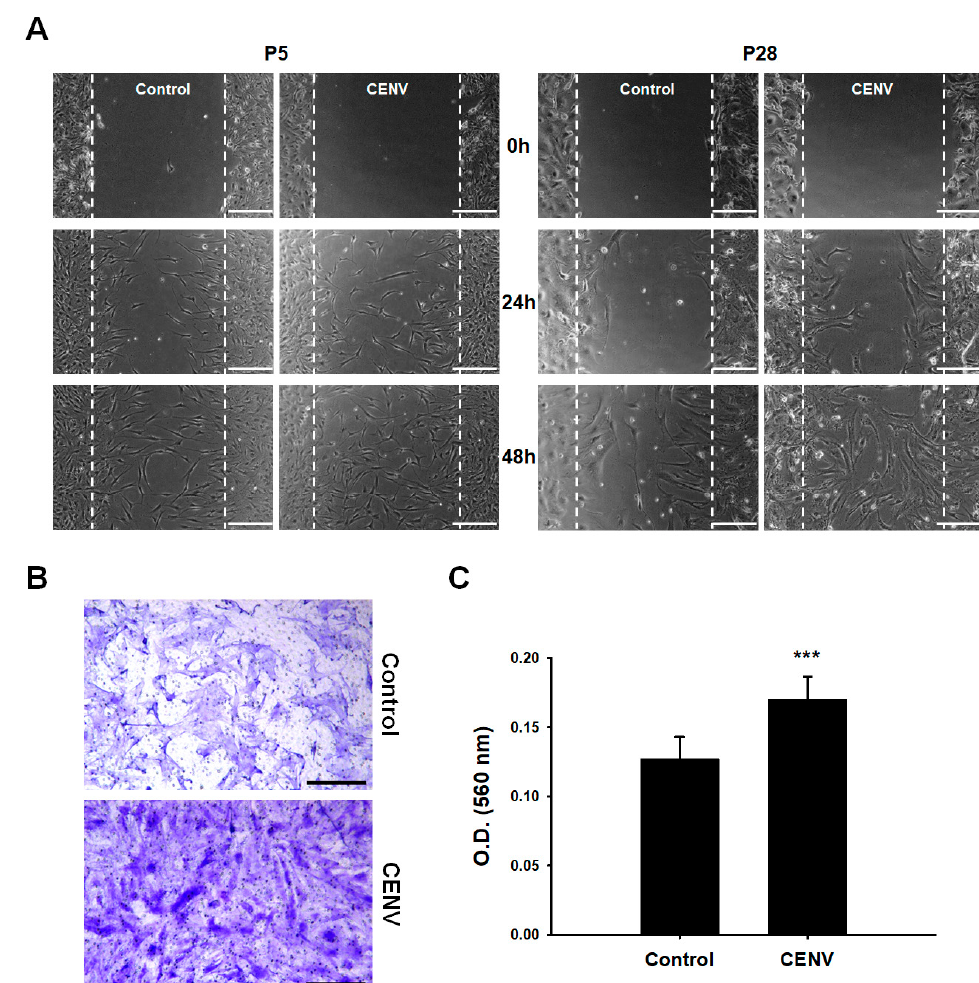
Figure 5. E ff ect of iPSC-CENV on the migration of HDFs. ( A ) Scratch closure assay for HDFs treated with iPSC-CENVs (scale bar = 250 µ m). Serum-starved HDFs were treated with particle number 2 × 10 9 /mL of iPSC-CENVs. Dashed lines indicate the initial scratched area. The rate of gap-filling was estimated using phase-contrast microscopy. ( B ) Representative image of a transwell migration assay (scale bar = 250 µm). Senescent HDFs seeded onto the upper side of a porous membrane migrated to the bottom side through the membrane. After 24 h treatment with iPSC-CENVs, the cells that had passed through a porous membrane were fixed with 4% paraformaldehyde, and stained with crystal violet. ( C ) Quantitative analysis of a transwell migration assay. After removing the remaining cells on the upper side, the porous membrane with the stained cells was cut out, and immersed in a 50% acetic acid solution to dissolve the crystal violet. The intensity of staining was measured using spectrophotometry as absorbance at 560 nm. Statistical significance (*** p <0.005 compared to the iPSC-CENV-untreated group) was determined using Student’s t -test. Error bars indicate the standard deviation of triplicate experiments.